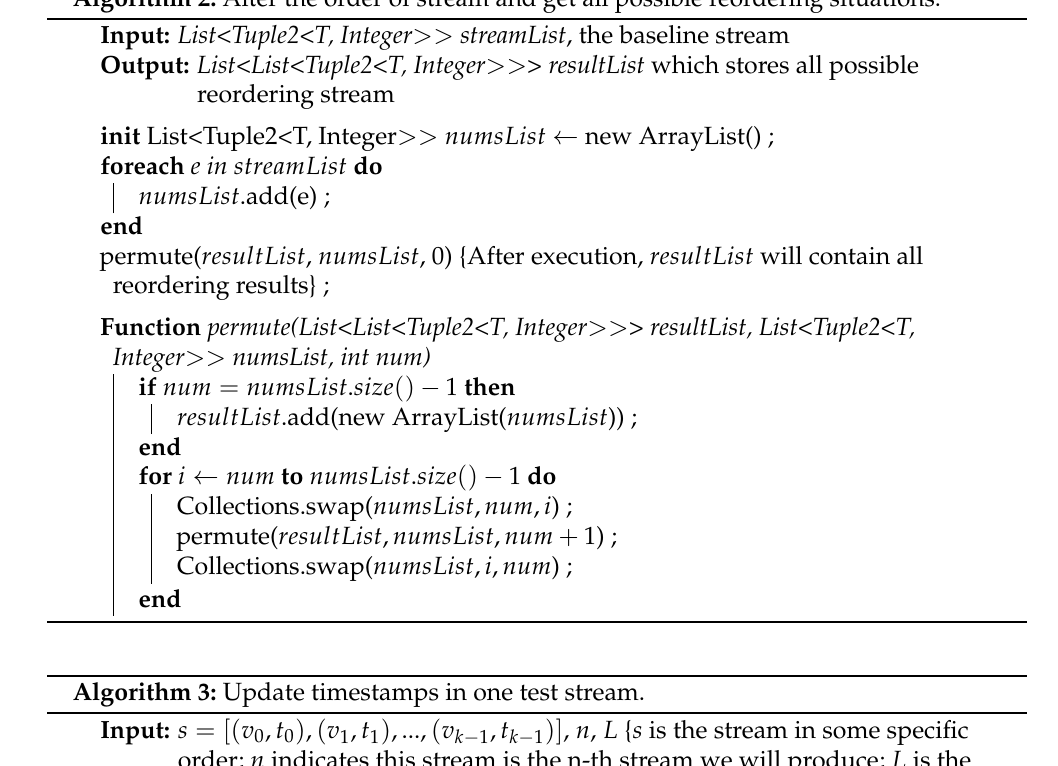
Algorithm 2: Alter the order of stream and get all possible reordering situations.